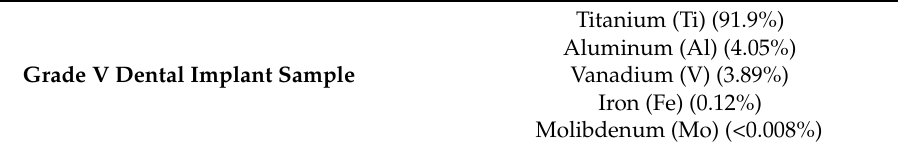
Table 2. Dental implant titanium alloys XRF (X-Ray Fluorescence)